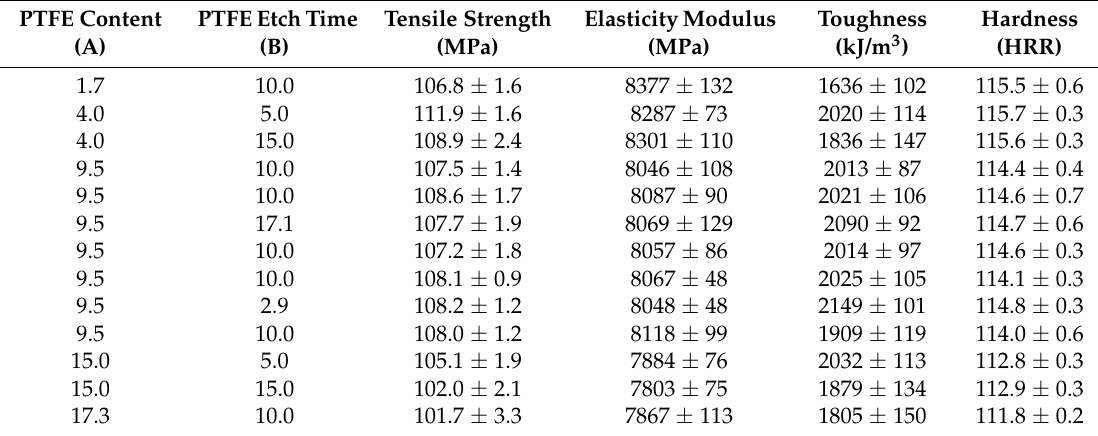
Table 2. Central composite design (CCD) in uncoded factors with tensile strength, elasticity modulus, toughness, and hardness as responses.